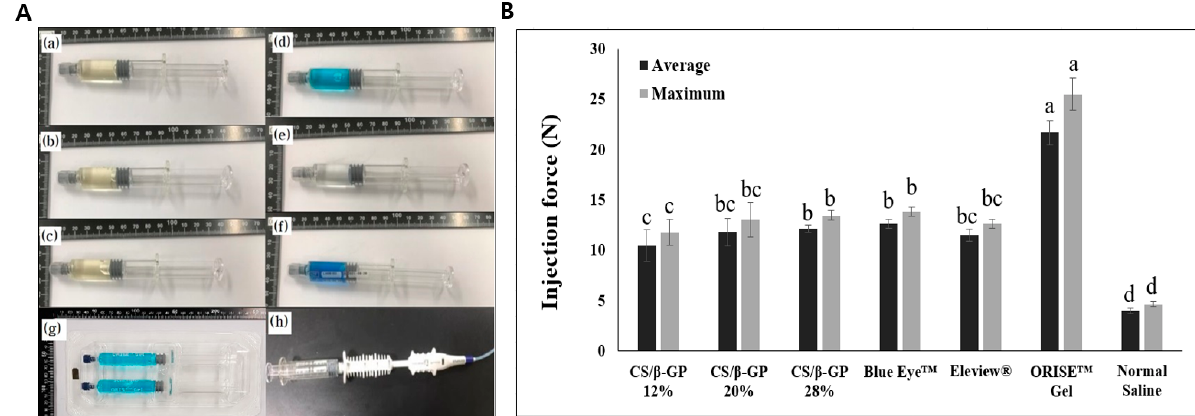
Figure 4. ( A ) Various submucosal injection agents to evaluate injection force; ( a ) CS/ β -GP 12% ( b ) CS/ β -GP 20% ( c ) CS/ β - GP 28% ( d ) Eleview ® ( e ) normal saline ( f ) Blue Eye™ ( g ) ORISE™ gel ( h ) Endoscopic needle. ( B ) Injectability of the chitosan thermosensitive solutions (CS/ β -GP 12%, CS/ β -GP 20% and CS/ β -GP 28%) and existing commercial submucosal injection agents. The average injection force and the maximum injection force were recorded for each sample (n = 5, ANOVA, Fisher’s LSD test, p < 0.05). Same letters indicate that there is no statistically significant difference between the samples.